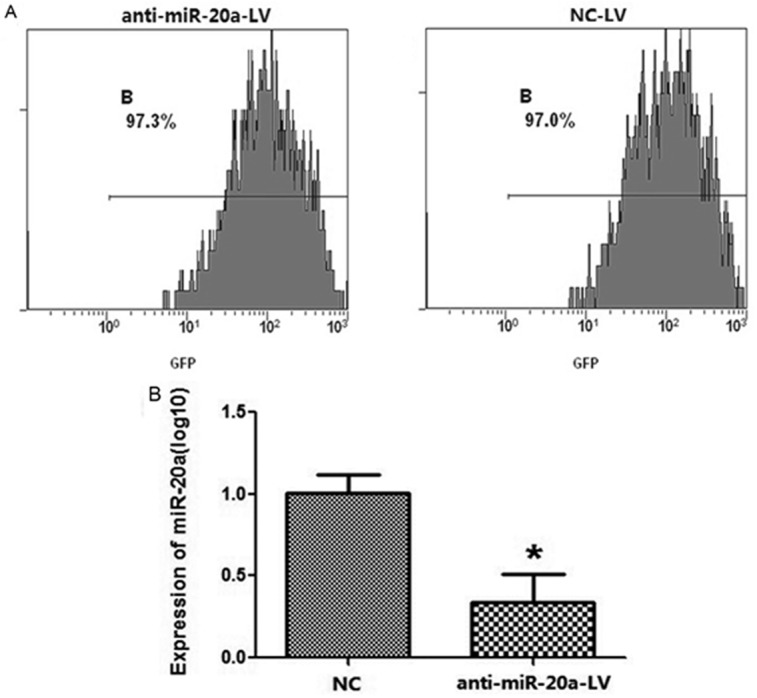
Establish the stable anti-miR-20a cervical cancer cell lines by lentivirus.A: GFP labeling flow cytometry analysis indicated that the percent of GFP positive cells were about 97% in stable lentivirus-infected SiHa cell line. B: MiR-20a was lower expressed in stable anti-miR-20a SiHa cell line while the expression level of miR-20a was still very high in cells infected with negative control.